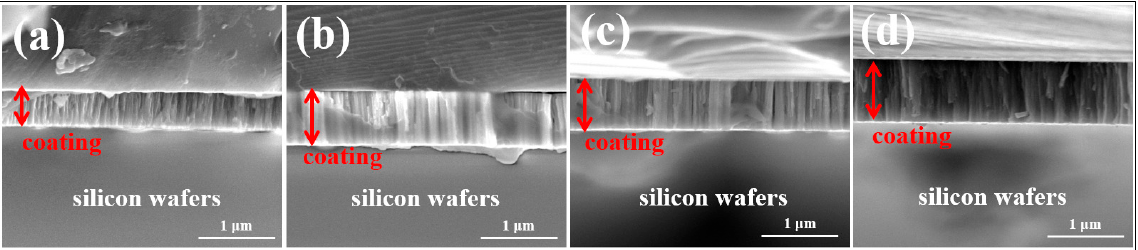
Figure 1. Cross-sectional images of films prepared at different sputtering pressures: ( a ) 0.4 Pa, ( b ) 0.6 Pa, ( c ) 0.8 Pa and ( d ) 1.0 Pa.